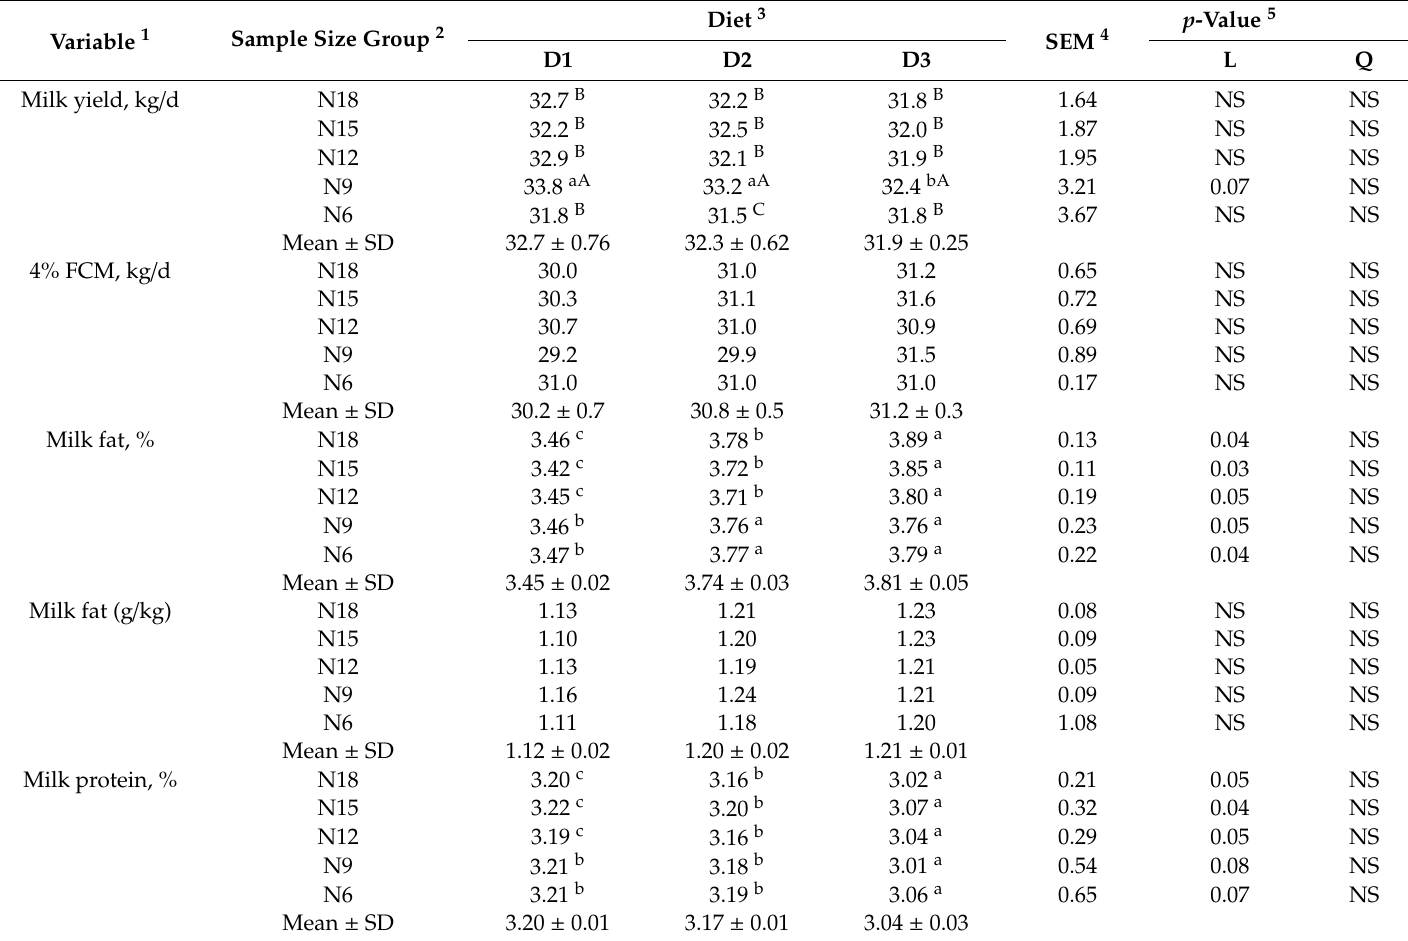
Table 5. E ff ect of diet on milk yield and composition of dairy cows fed corn-based diets in di ff erent sample size groups ( n = 162). Variable